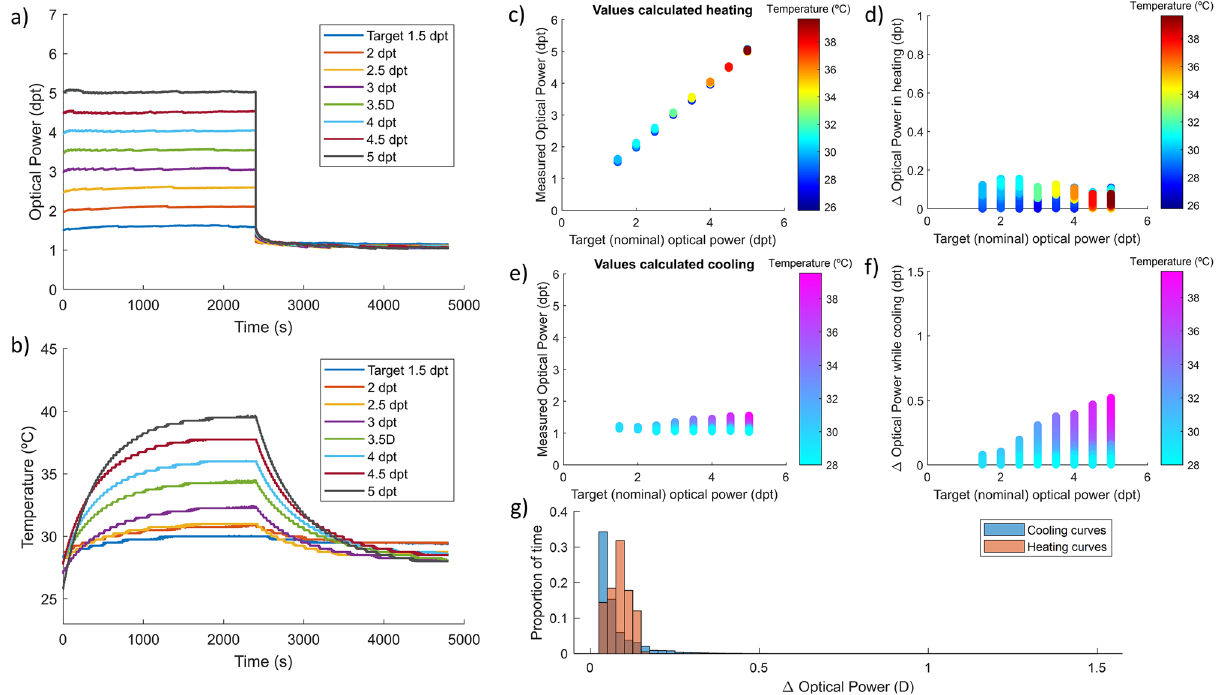
Figure 2. Optimized model compensation of temperature effect in a TL during long static states of different optical power. ( a ) Graphical description of the result of compensation strategy showing the optical power stabilization in time. ( b ) Internal temperature profile of the lens during the experiment with different target power states. Measured optical power of the lens while heating ( c ) for different driving signals and cooling ( e ) at rest state. Estimated deviation, calculated from the difference between target power and measured optical power in the heating ( d ) and cooling ( f ) processes. ( g ) Histogram of optical power deviation while heating (red) and cooling